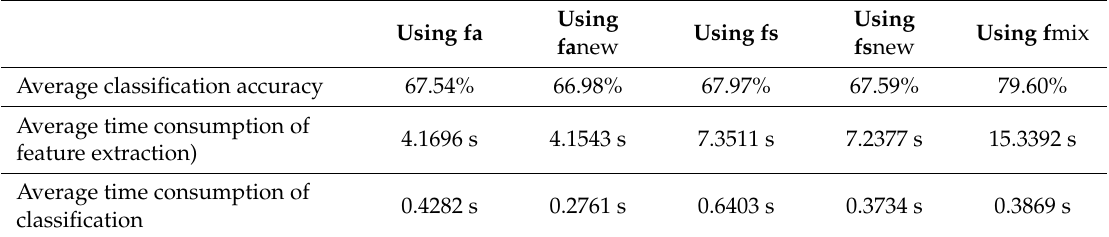
Using Using Using fa Using fs Using f fa new